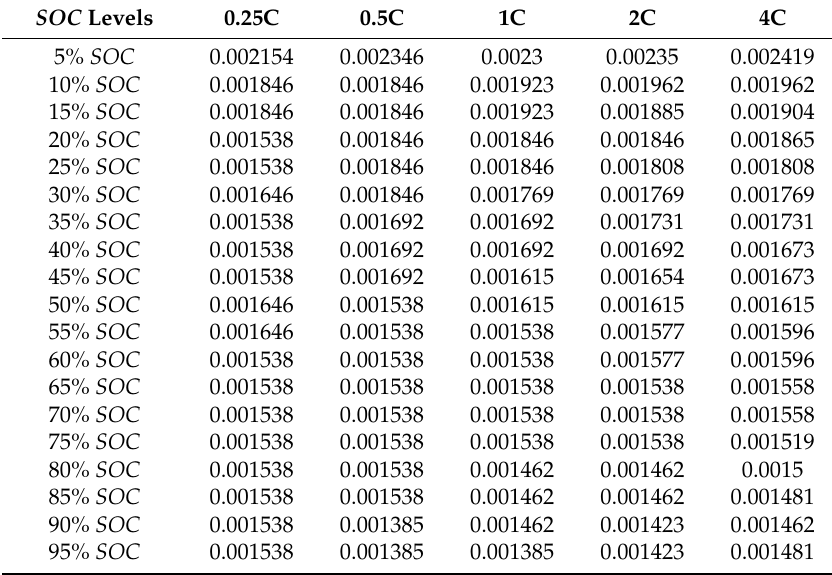
Figure 3. Voltage variations for a discharging pulse and voltage one second after current pulse. Table 3. 2-D lookup table for determination of ohmic resistance ( Rs ).